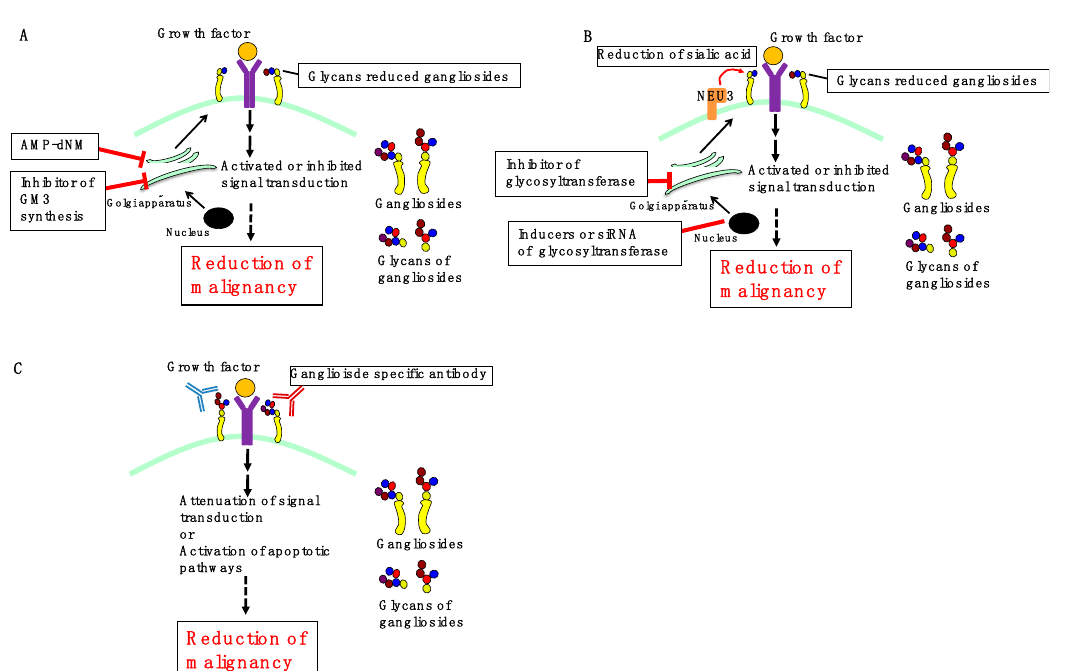
Figure 4. Three possible ganglioside-targeting strategies for cancer therapy. ( A , B ) Treatment with glucosylceramide synthase inhibitors such as AMP-dNM or specific inhibitors of GM3 synthase reduces glycans in gangliosides ( A ). Furthermore, treatment with an inhibitor of glycosyltransferases, or inducers or siRNA of glycosyltransferase or NEU3 reduces glycans in gangliosides ( B ). This affects the interaction of glycan-reduced gangliosides and receptors, activating or inhibiting signal, reducing malignancy. ( C ) Treatment with ganglioside-specific antibody contributes to attenuation of signal transduction or activation of apoptotic pathways, leading to reduced malignancy.